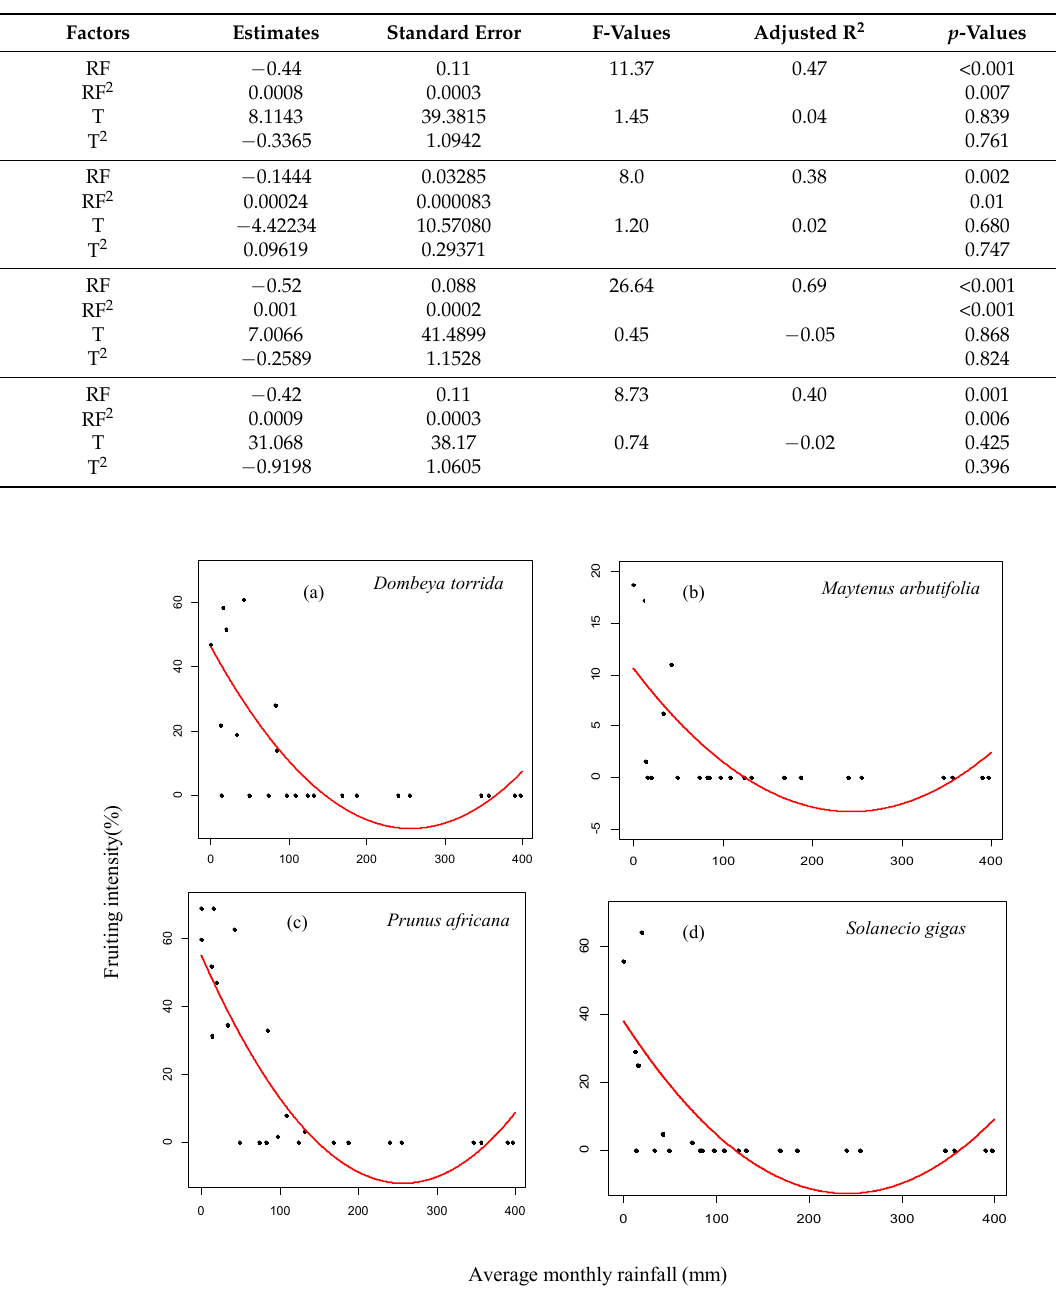
Figure 12. Patterns of the fruiting intensity in relation to monthly rainfall: ( a ) Dombeya torrida , ( b ) Maytenus arbutifolai , ( c ) Prunus africana and ( d ) Solanecio gigas .